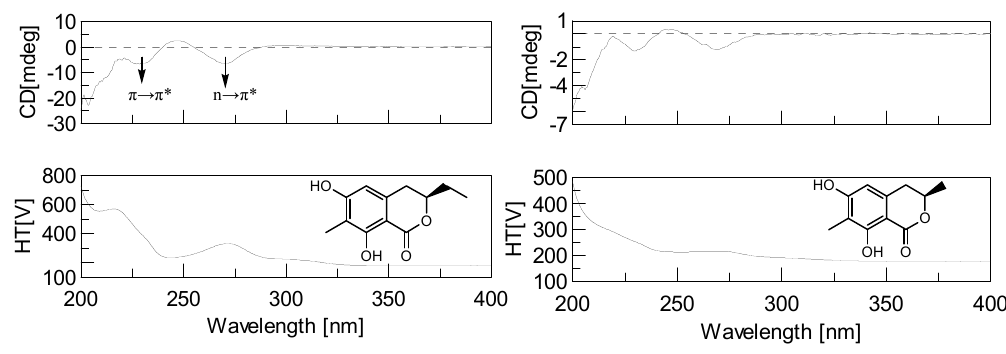
Figure 5. The CD spectra of attractants 1 and